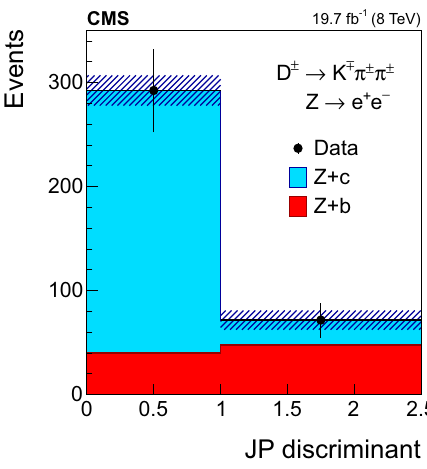
Fig. 8 Background-subtracted distributions of the JP discriminant in the dielectron (left) and dimuon (right) channels for Z + jets events with a D ± → K ∓ π ± π ± candidate. The shape of the Z + c and Z + b contributions is estimated as explained in the text. Their normalization is adjusted to the result of the signal extraction fit. Vertical bars on